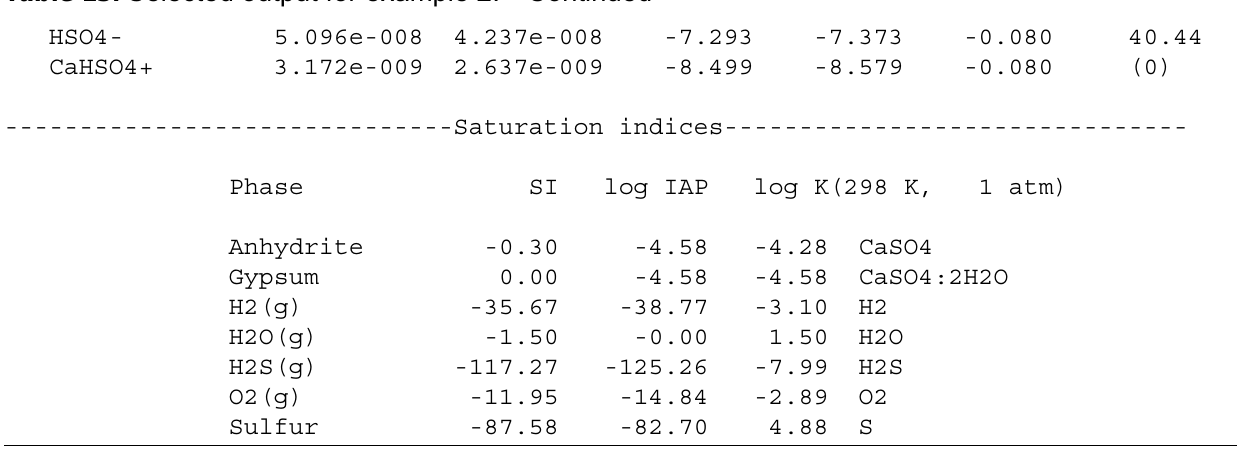
Table 13. Selected output for example